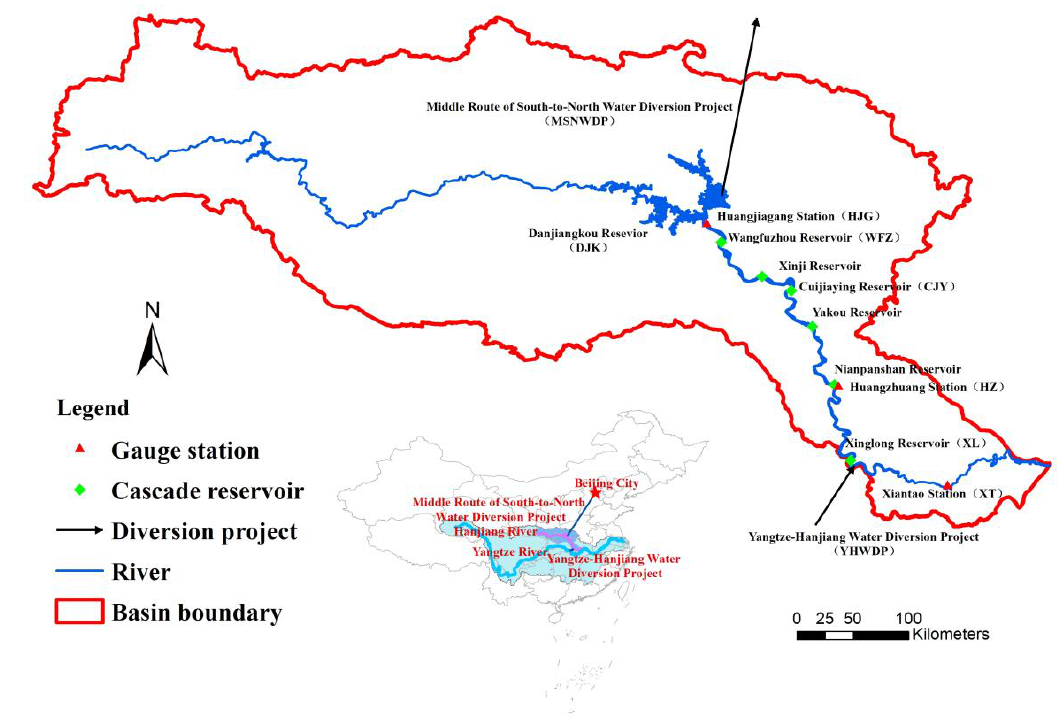
Figure 1. Location of projects and gauge stations in the mainstream of the middle-lower reaches of the Hanjiang river. Table 1. Characteristics of the main projects in the Hanjiang river.